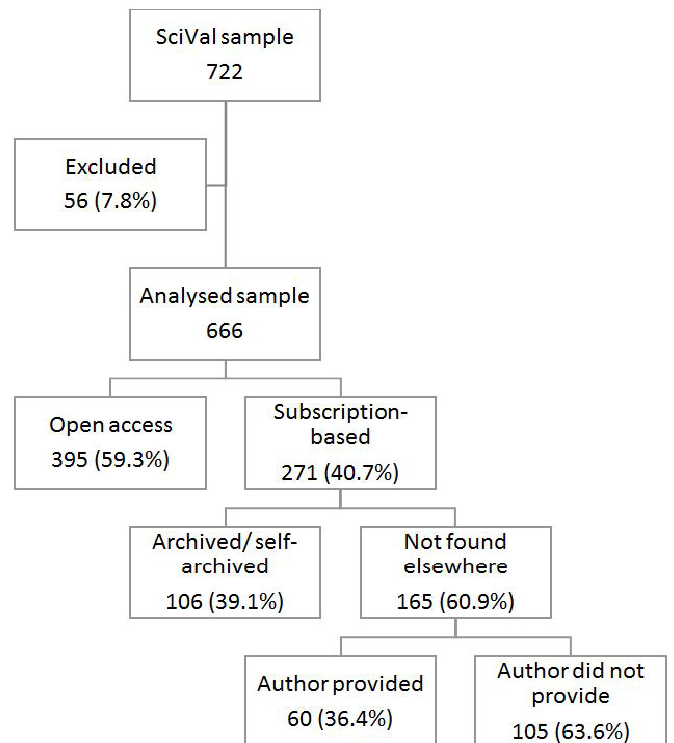
Figure 1 . Sample derivation and main findings of the study (numbers of published